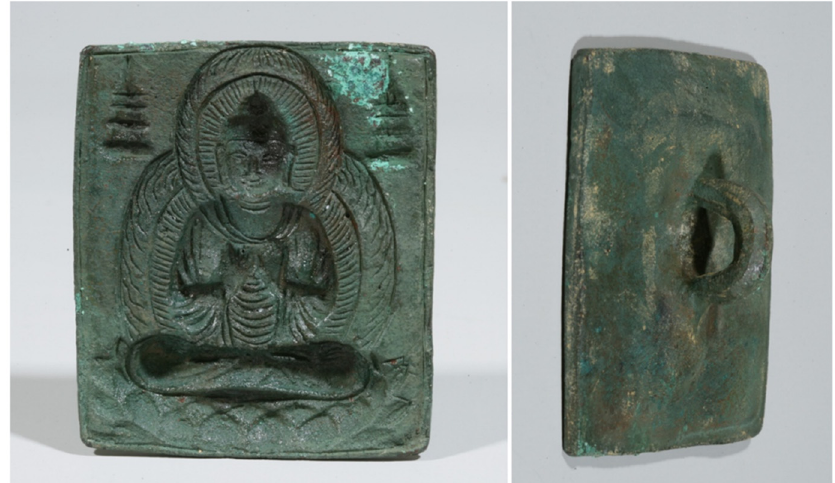
Figure 1. Bronze Buddha mold ( left ) front of mold ( right ) back of mold, Unified Silla, late seventh-to-eighth century, 7.1 × 8.2 cm . Western pagoda of Hwa ŏ m temple, Hwa ŏ msa Buddhist Museum [©CBM].